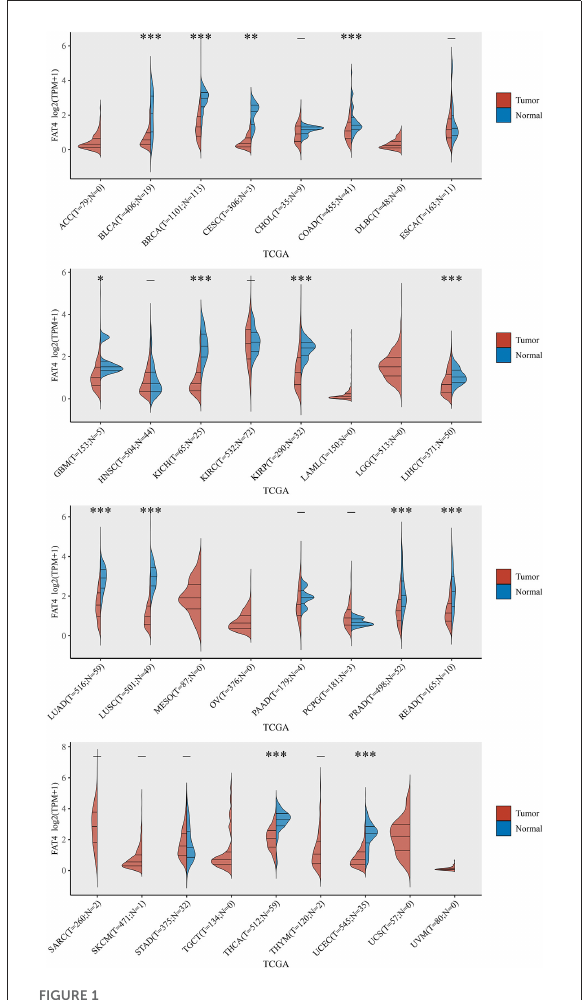
FIGURE1 The expression level of FAT4 gene in different tissues. Red represents the tumor tissue, blue represents the normal tissue, X-axis represents the tumor type, and Y-axis represents the expression level of FAT4. *Appears above the tumor, FAT4 expression level is different between the tumor group and the normal group in this tumor type. *Represents P -value < 0.05; **represents P -value < 0.01; ***represents P -value <